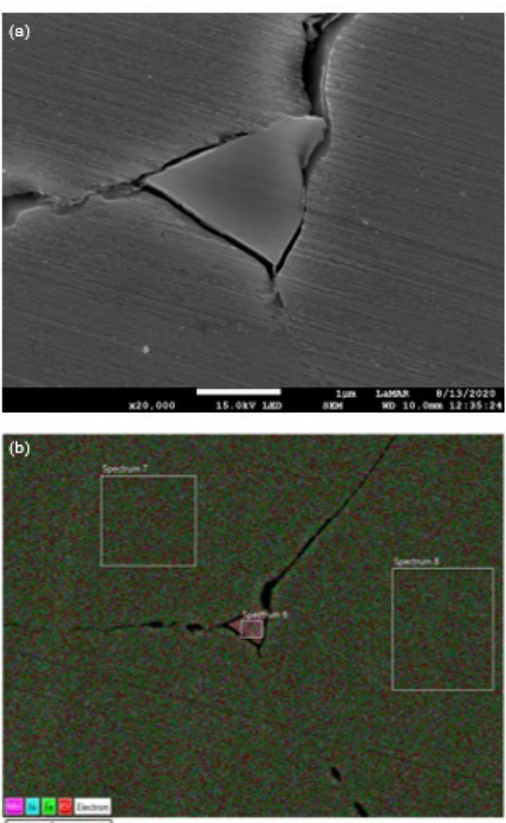
Figure 6. Degree of sensitization (Ir / Ia) of AL-6XN PLUS samples versus aging time at 600ºC.